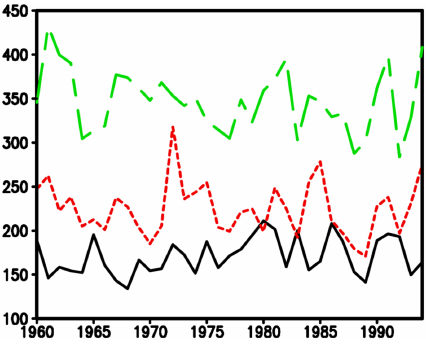
Figure 3. The time series of the WVT intensities from the western North Pacific (solid line; black), the South China Sea (short dotted line; red), and the Bay of Bengal (long dotted line; green) from 1960 to 1994. The units are kgcm − 1 s − 1 . Table 2. The mean and standard deviation of the WVT intensities from the Bay of Bengal, the South China Sea, and the western North Pacific from 1960 to 1994. The unit is kgcm − 1 s − 1 . The Bay of The South The western Bengal China